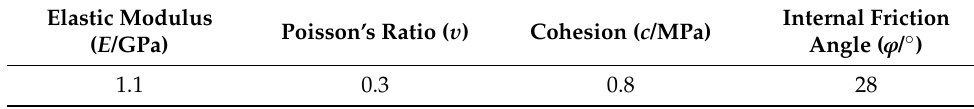
Table 2. Mechanical parameters of coal samples.